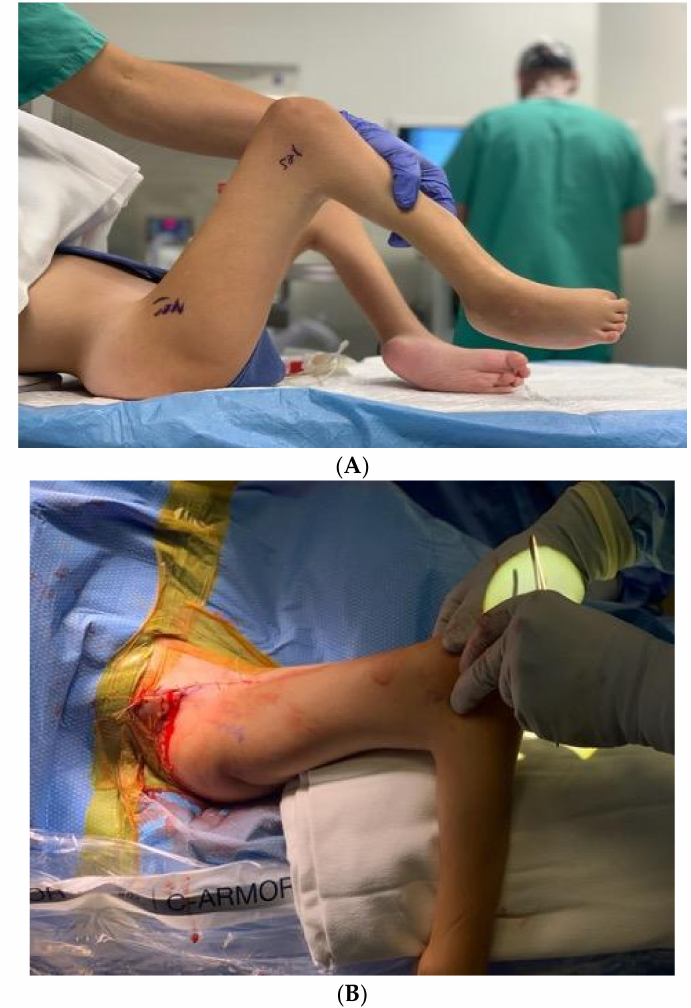
Figure 10. ( A ) Preoperative hip flexion contracture >70 ◦ ; ( B ) post hip flexor release with less than 20 ◦